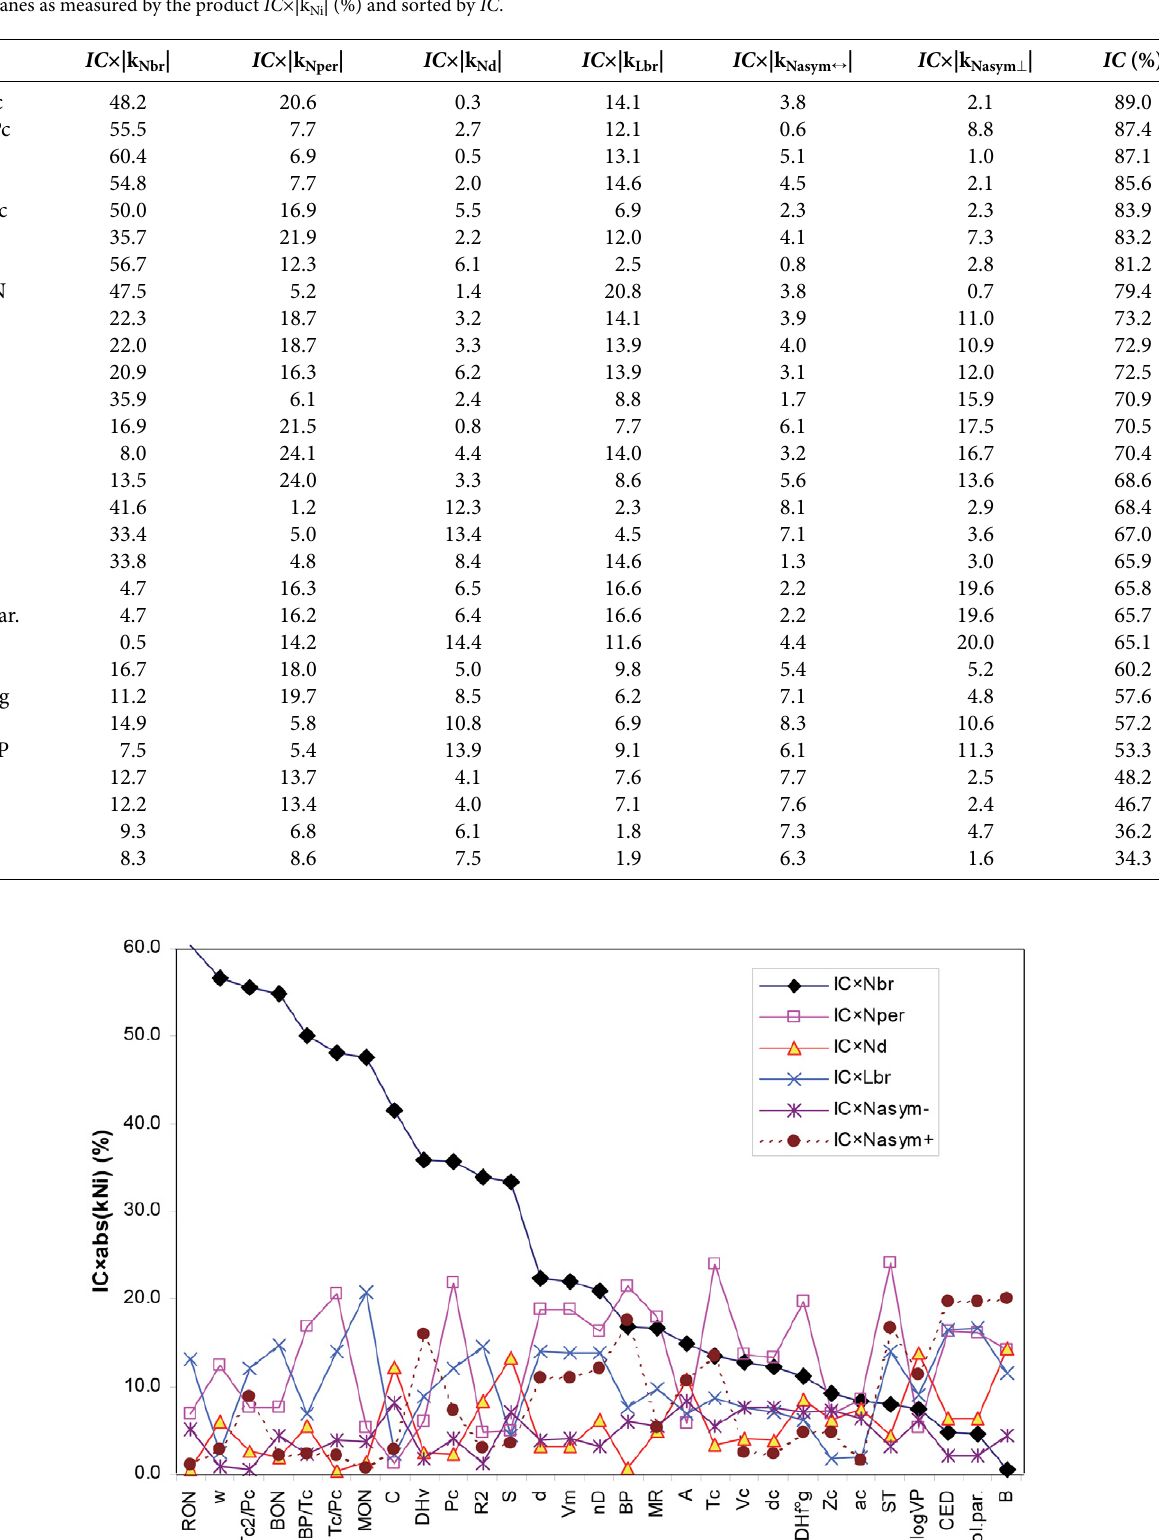
Table 4. Information contribution of the Structural Numbers N br , N per , N d , L br , N asym ↔ , and N asym ^ to the values of physicochemical properties of octanes as measured by the product IC ×|k Ni | (%) and sorted by IC .